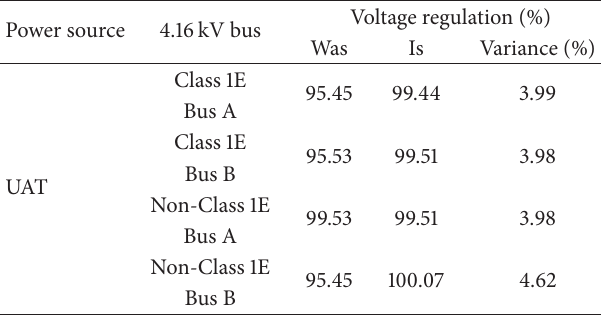
Table 10: Variance in voltage during the plant start-up condition (Cat. I).